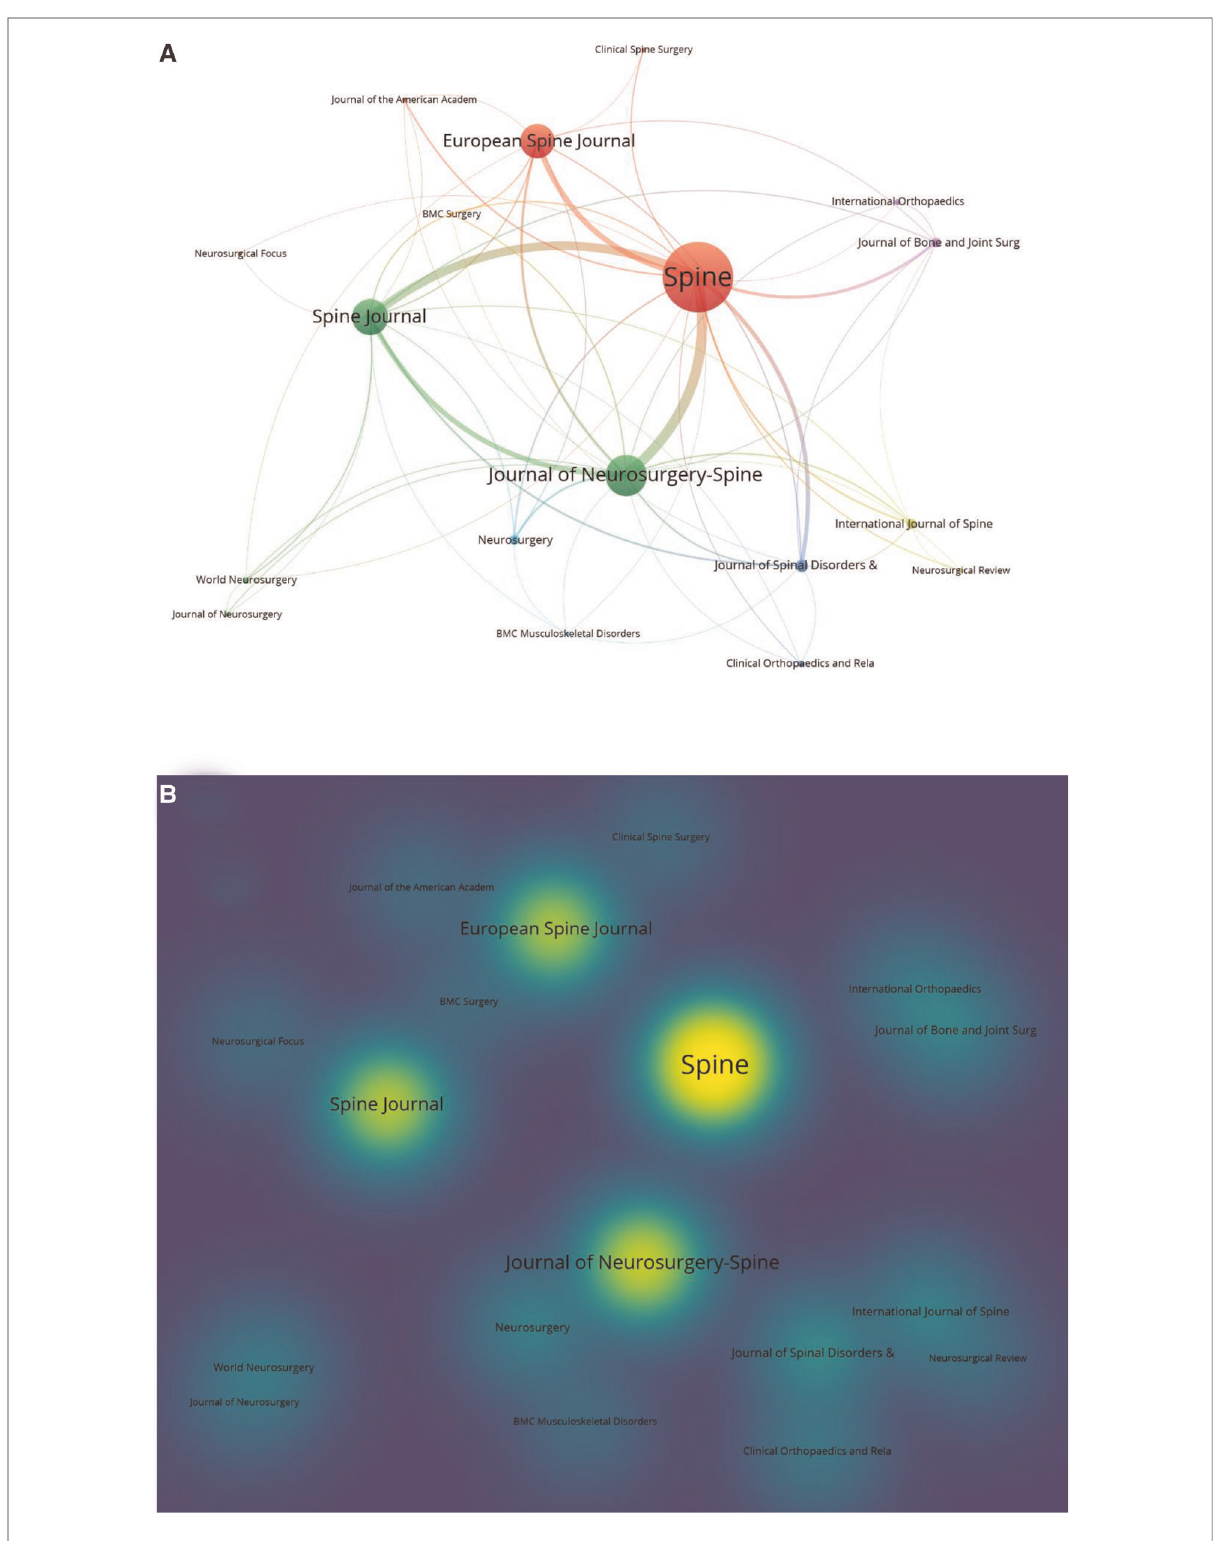
FIGURE 4 Degree of centrality analysis of the journals of the whole 100 top-cited articles. ( A ) Overlay visualization. ( B ) Hotmap overlay visualization.